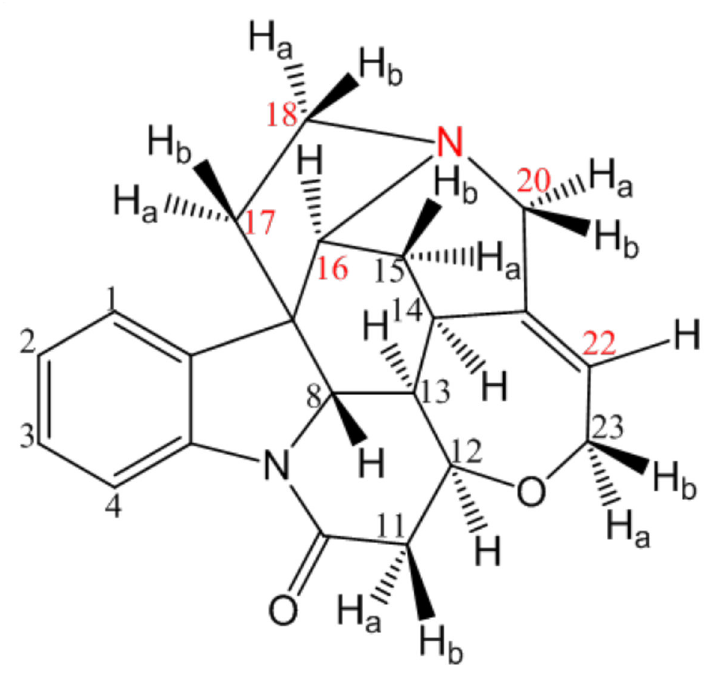
Figure 1. The chemical structure of